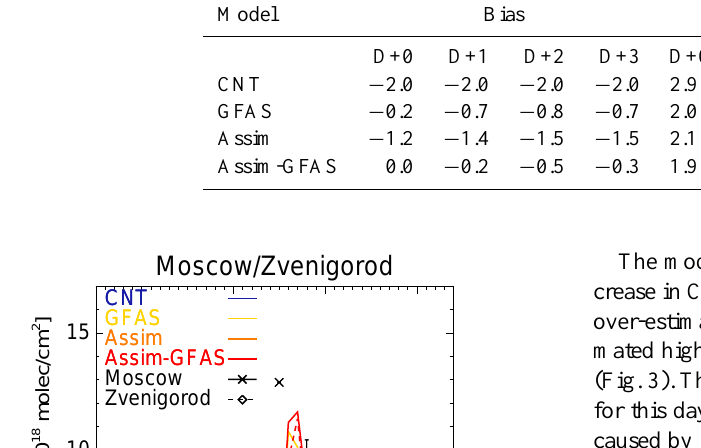
Table 7. Mean bias and RMSE of modeled total CO columns (units 10 18 moleccm − 2 ) compared to ground-based CO total column observa- tions at the Moscow and Zvenigorod stations between 20 July and 15 August, as function of the hindcast day. Model Bias